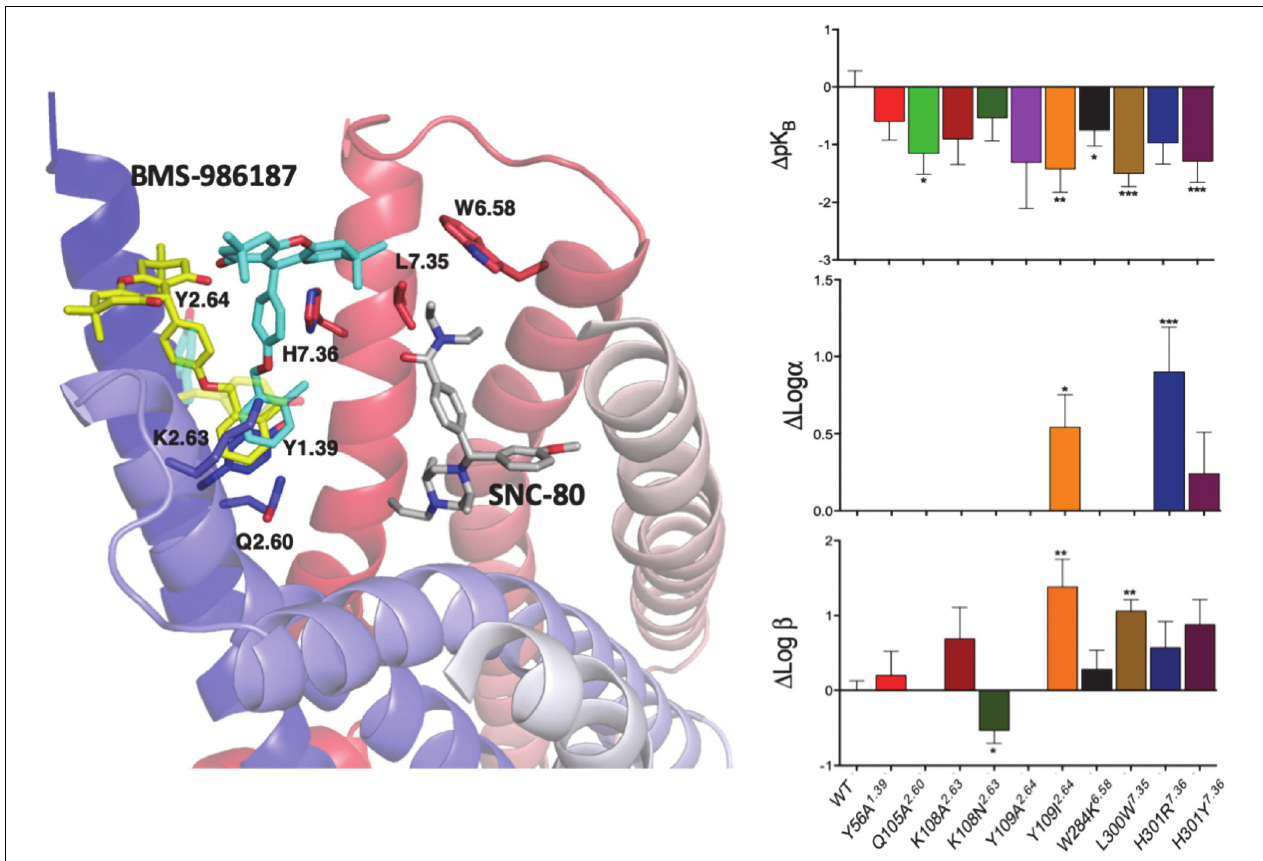
FIGURE 4 | The two energetically most favorable binding modes of the allosteric modulator BMS-986187 – colored yellow and cyan – at the DOP receptor in complex with the orthosteric ligand SNC-80, which is colored in gray. In sticks are the DOP receptor residues in the putative DOP allosteric site used in mutagenesis experiments to help validate the most likely binding mode. The plots to the right show the effect of mutations on the affinity of the allosteric ligand (top right), the induced changes in affinity of the orthosteric ligand (middle plot), and the changes in orthosteric ligand efficacy when the allosteric ligand is bound (bottom right). The experimental data support the predicted BMS-986187 binding mode in cyan color as the most favorable one. Astars indicate the statistical significance levels as given by Dunnet’s test p values ( ∗ p < 0.05, ∗∗ p < 0.01, and ∗∗∗ p <